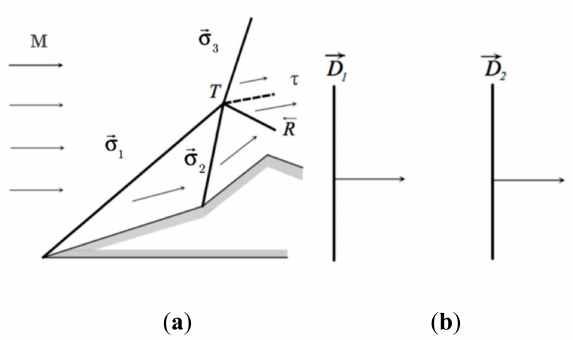
Figure 1. Interference of shock waves in one direction: ( a ) oblique shock waves in one direction, ( b ) overtaking one-dimensional shock waves D 1 and D 2 (arrows show the direction of motion of shock